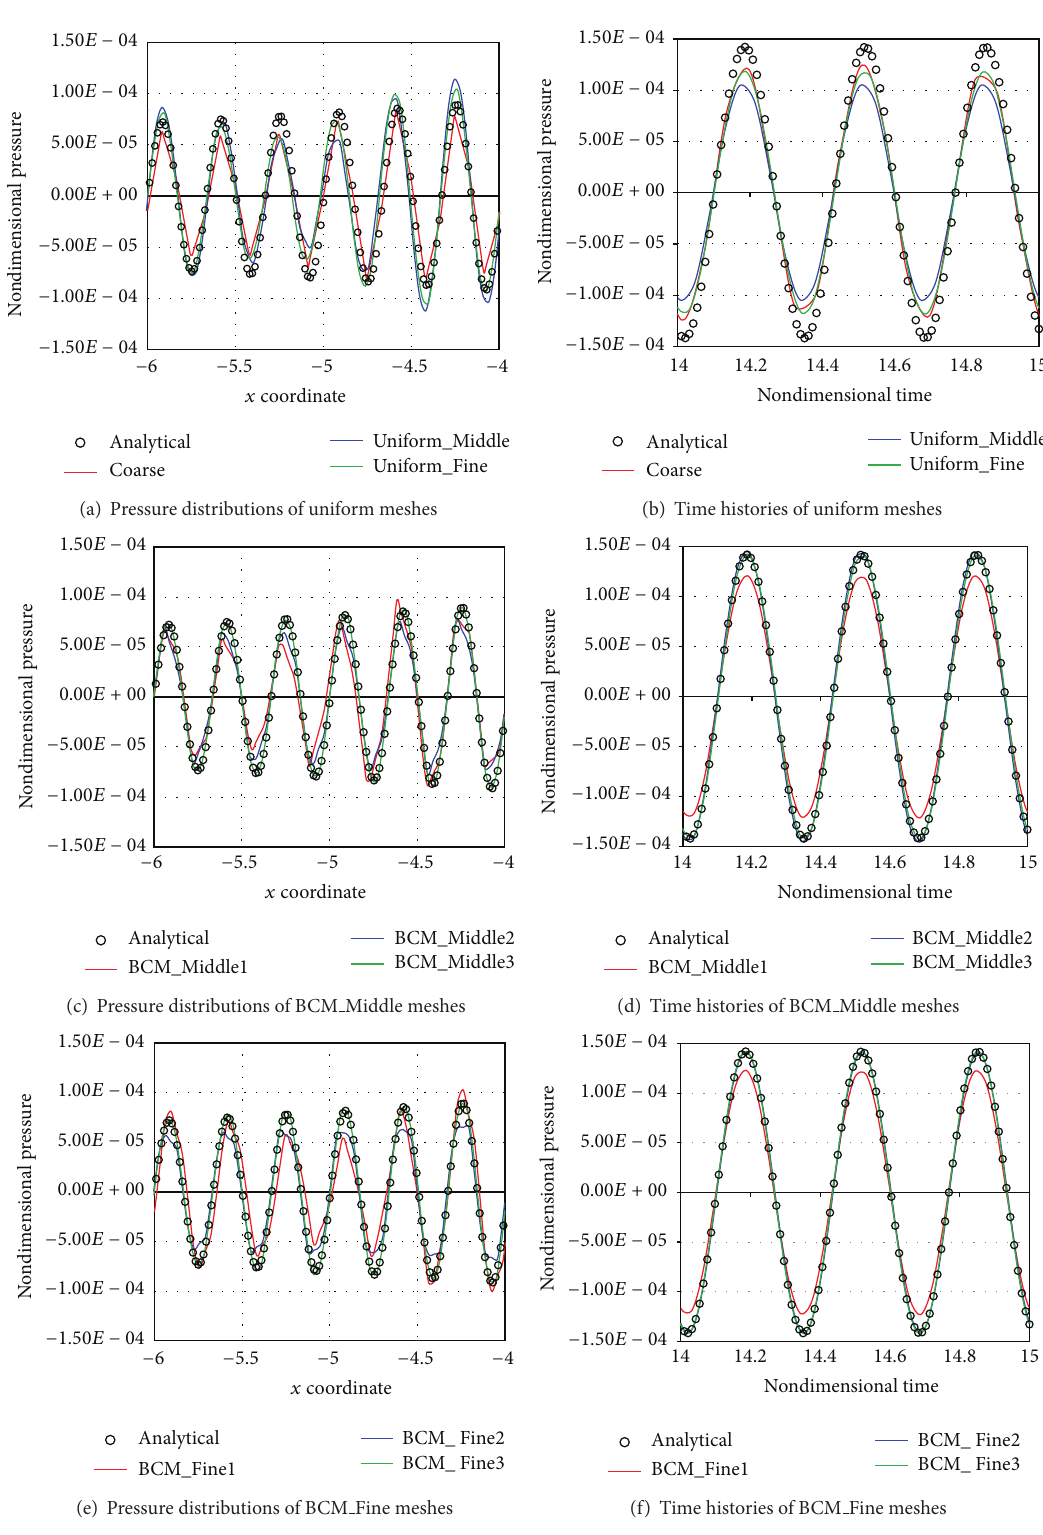
Figure 9: Pressure distributions ( −6𝐷 ≤ 𝑥 ≤ −4𝐷 ) and time histories at ( − 2 D , 0, 0) and ( 14 ≤ 𝑇 ≤ 15 ) around a sphere of diameter 𝐷 for the meshes listed in Table